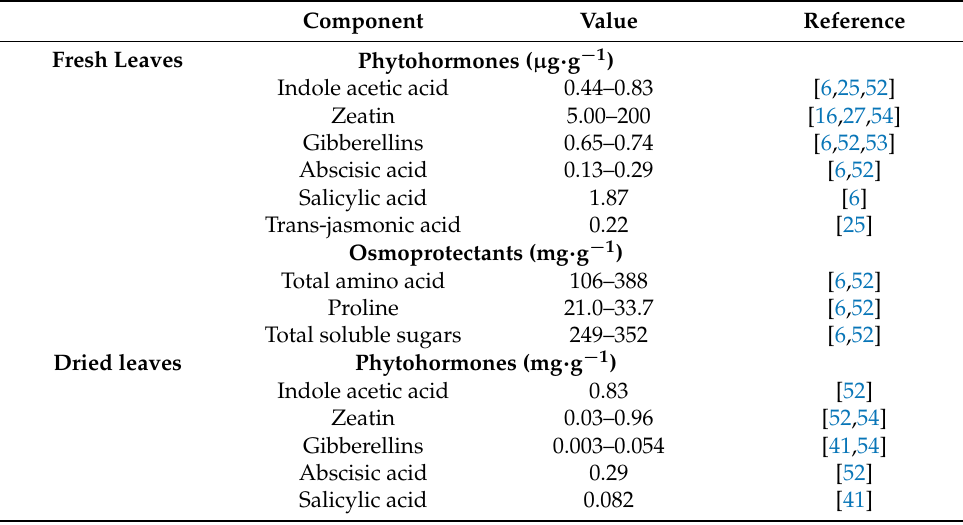
Table 3. Phytohormonal profile and osmoprotectant concentrations of moringa